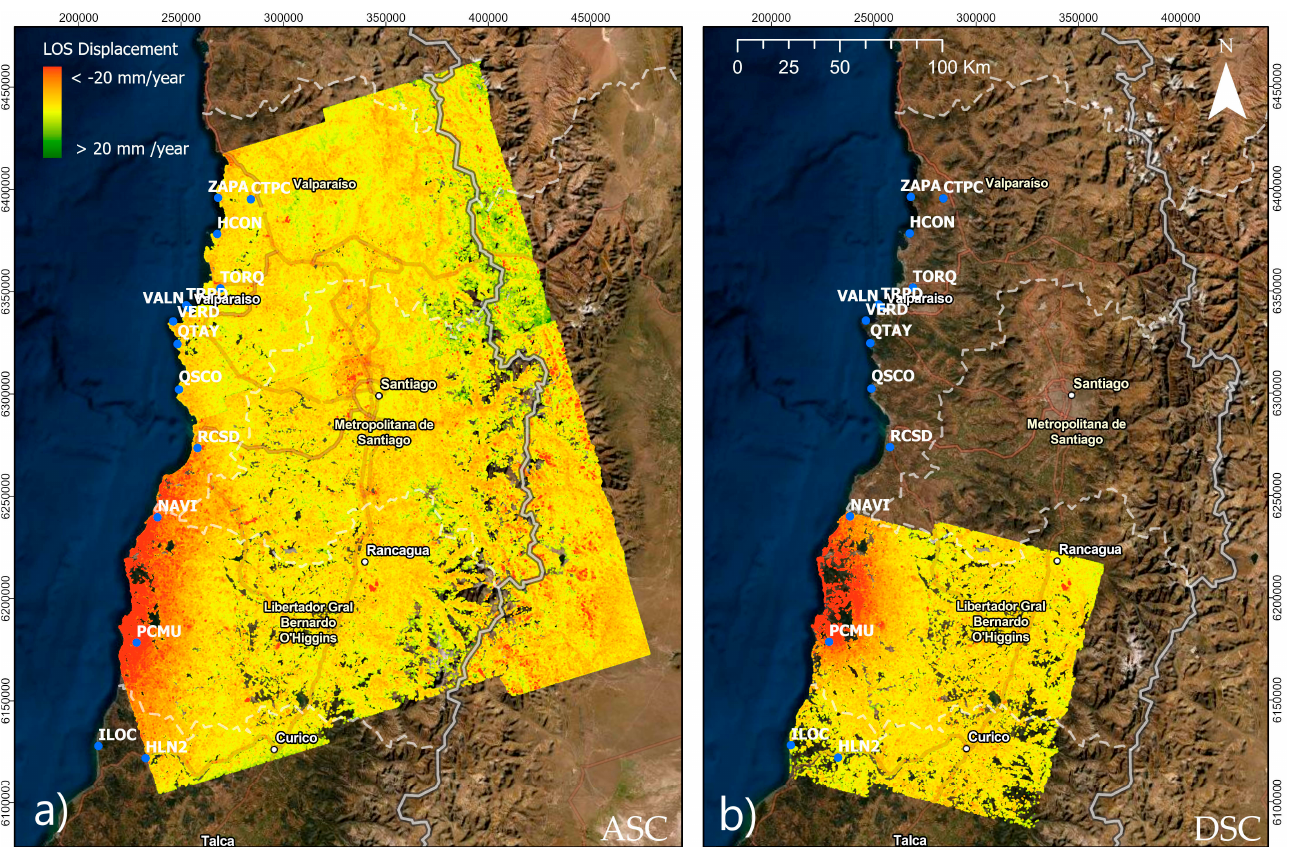
Figure 5. Regional displacement overview maps (mm/year), with ( a ) representing ascending orbit 18ASC and ( b ) descending orbit 156DSC, for the MT-InSAR observation period 2018–2021. The subsidence detected is red for the SW area.